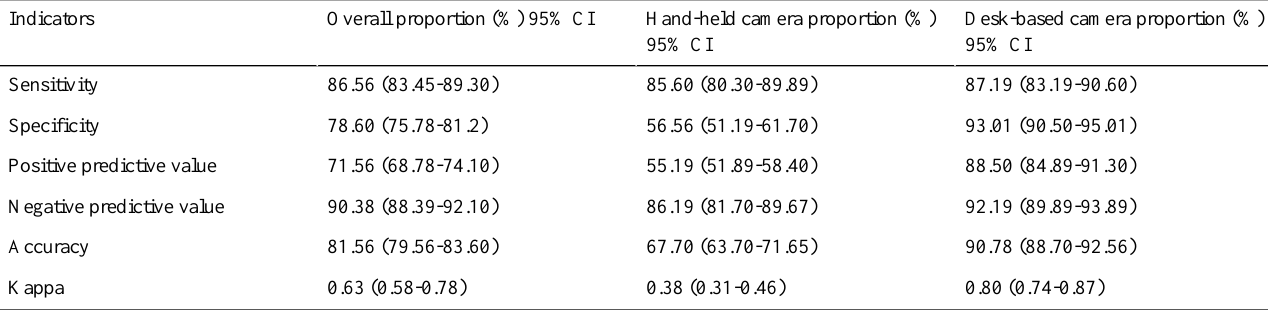
Table 2. Diagnostic accuracy of diabetes retinopathy by instrument type in 6 selected peripheral hospitals in Bangladesh from July 2017 to June